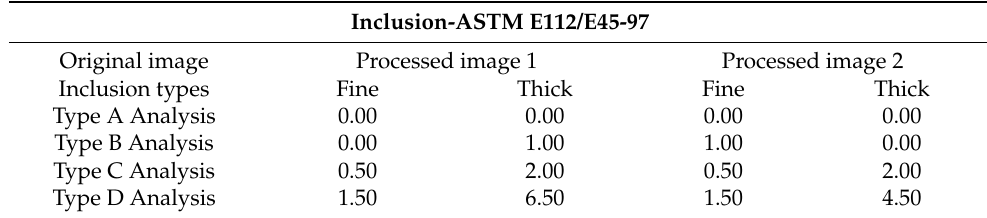
Table 1. Inclusion analysis made with Material Plus software.